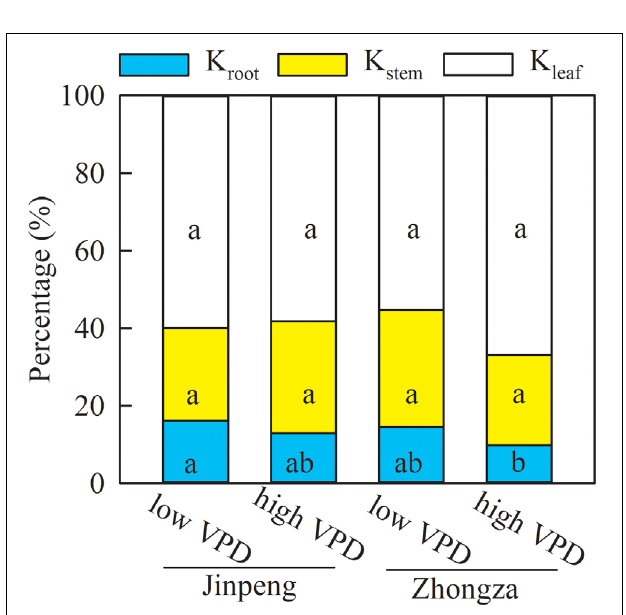
FIGURE 3 | Percentage contributions of leaf (K leaf ), stem (K stem ), and root (K root ) hydraulic conductance to whole plant hydraulic conductance for two tomato cultivars, Jinpeng and Zhongza, grown under low (1.1–1.5 kPa) and high (2.2–2.6 kPa) VPD. Different letters denote statistically significant differences (Duncan’s test, P <